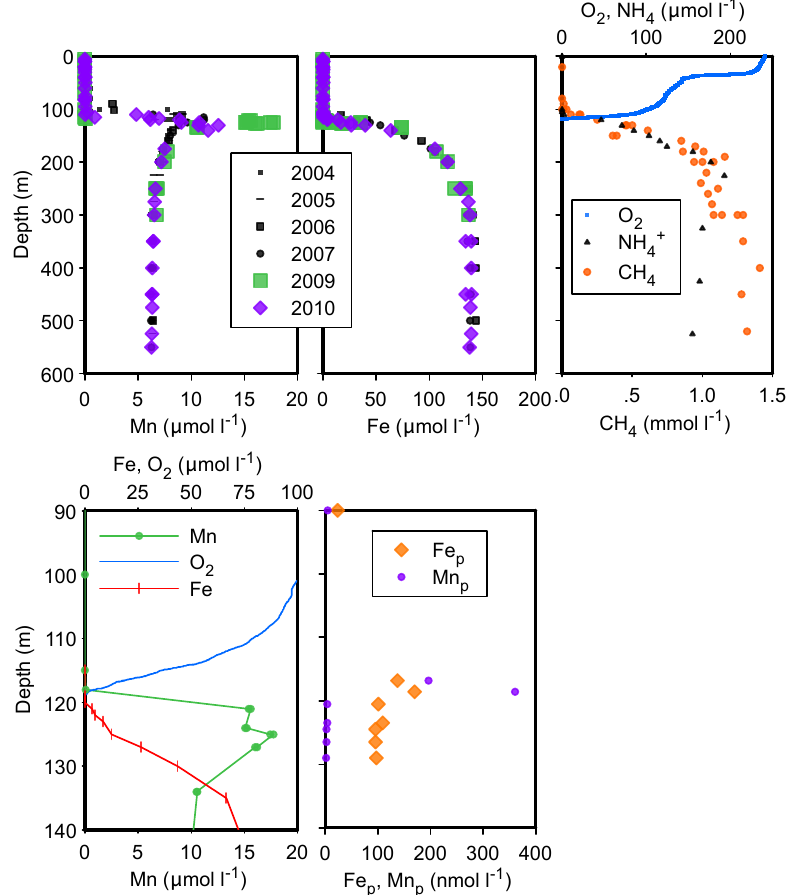
Fig. 3. Lake Matano water column profile of dissolved Mn (left panel) and dissolved Fe (middle panel) from 2004 to 2010. Right panel shows representative dissolved O 2 , NH + , and CH 4 profiles. CH 4 and NH + profiles are reproduced from Crowe et al. (2011). Bottom panels 4 4 are a closer view of the chemocline with the left panel displaying O 2 , dissolved Mn(II), and Fe(II), while the bottom right panel shows particulate Fe and